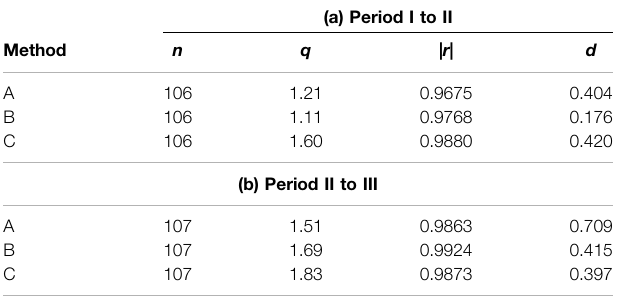
TABLE6| Comparisonofoptimal fi ttingparametersintherankdependenceofthe intersectingangle ofthemonthlyprecipitationsontheWorldstations. (a)From Period I (from 1931 to 1960) to Period II (from 1951 to 1980); (b) From Period II (from 1951 to 1980) to Period III (from 1981 to